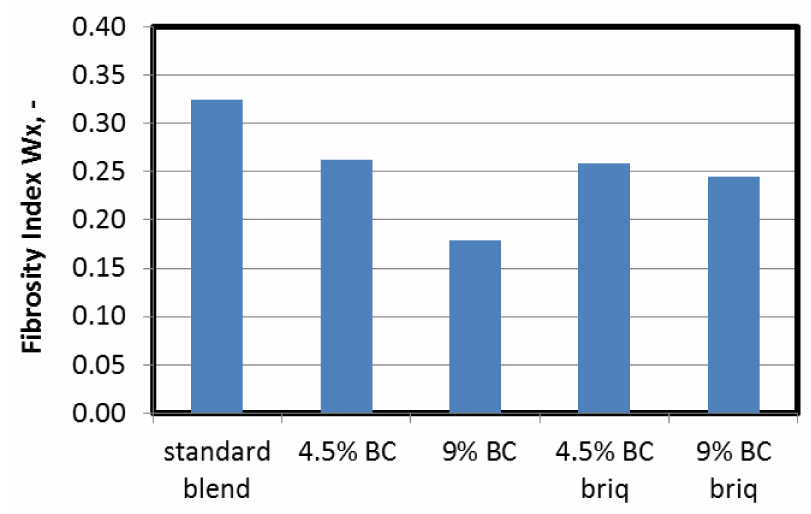
Figure 8. Influence of lignite addition on fibrosity index W x of cokes.